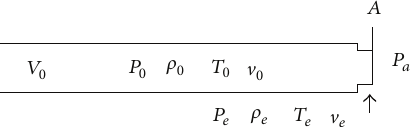
ejected from the hole. So the volume of detonation gas with time can be expressed as